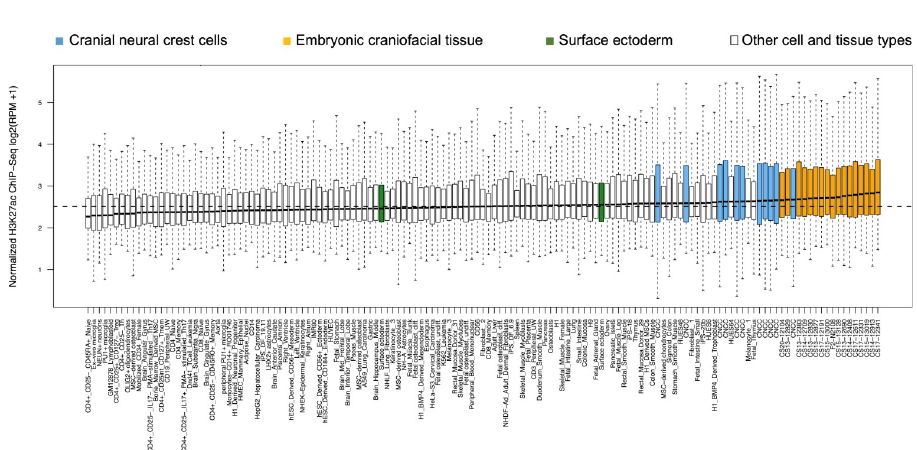
Fig 4. Preferential activity in CNCCs and embryonic craniofacial tissues. Boxplots of the distribution of H3K27ac ChIP-seq signals in 20 kb regions around the 218 genome-wide significant lead SNPs in various adult, embryonic and in vitro–derived cell types. Samples corresponding to CNCCs (blue), embryonic craniofacial tissue (orange) and surface ectoderm (green) are highlighted.